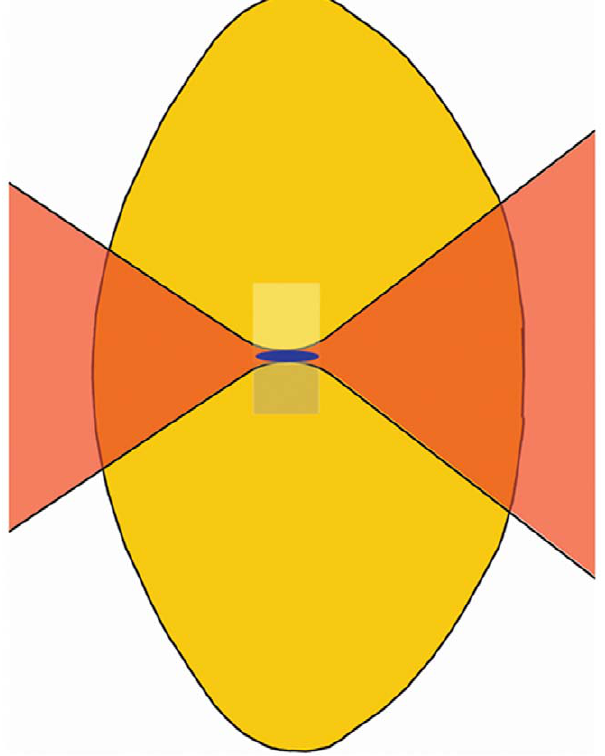
Figure 5. Schematic presentation of the laser treatment shown on a cross section of a lens in the sagittal plane. An infra-red laser (here shown in red) is focused inside a human donor lens. Emission of blue autofluorescence is seen in the focal region as a sign of two-photon absorption. The laser is scanned over the lens in a line-by-line raster pattern. The technical set-up only allowed for 2 directional scanning restricting the depth of the treatment plane to the Rayleigh length of focal region of the laser. Thus, a subvolume measuring 1.0 mm in height by 1.0 mm in width by 0.52 mm in depth was treated. The treated area is shown as a lighter area above the laser focal region and the area awaiting treatment is shown in a grey shade below the laser focal region.